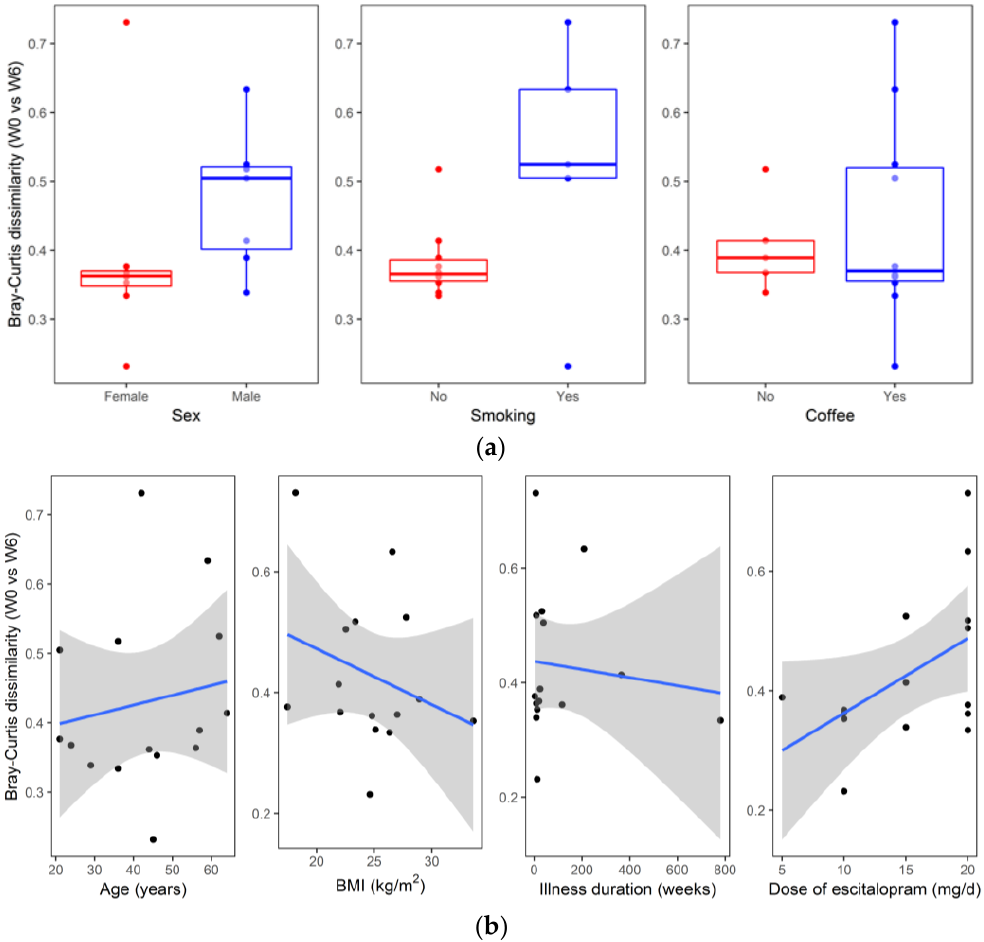
Figure 7. Same-donor Bray–Curtis dissimilarities (W0 vs. W6) association with sample metadata (age, sex, BMI, illness duration, smoking status, and coffee consumption). ( a ) The boxplots represent the within-subject (same donor) beta diversity measures, Bray–Curtis dissimilarities (center line—median, lower, and upper hinges correspond to the first (Q1) and third (Q3) quartiles; whiskers—the upper whisker is located at the smaller of the maximum beta diversity measures and Q3 + 1.5 × IQR (Q3 − Q1); the lower whisker is located at the larger of the minimum beta diversity measures and Q1 − 1.5 × IQR). ( b ) Correlations (scatter plots) between same-donor Bray–Curtis dissimilarities and sample metadata (age, BMI, illness duration and dose of escitalopram). The regression lines (colored blue) were fitted using the linear model; grey shading areas represent confidence bounds.